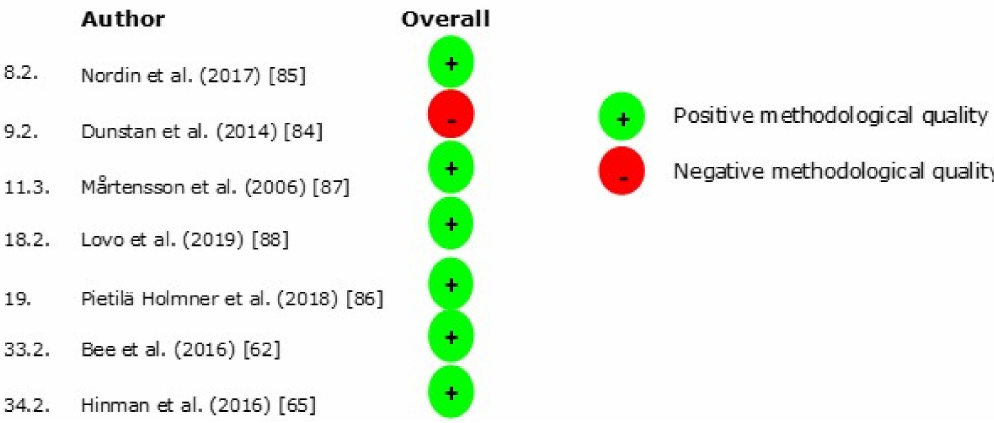
Figure 5. Critical appraisal qualitative